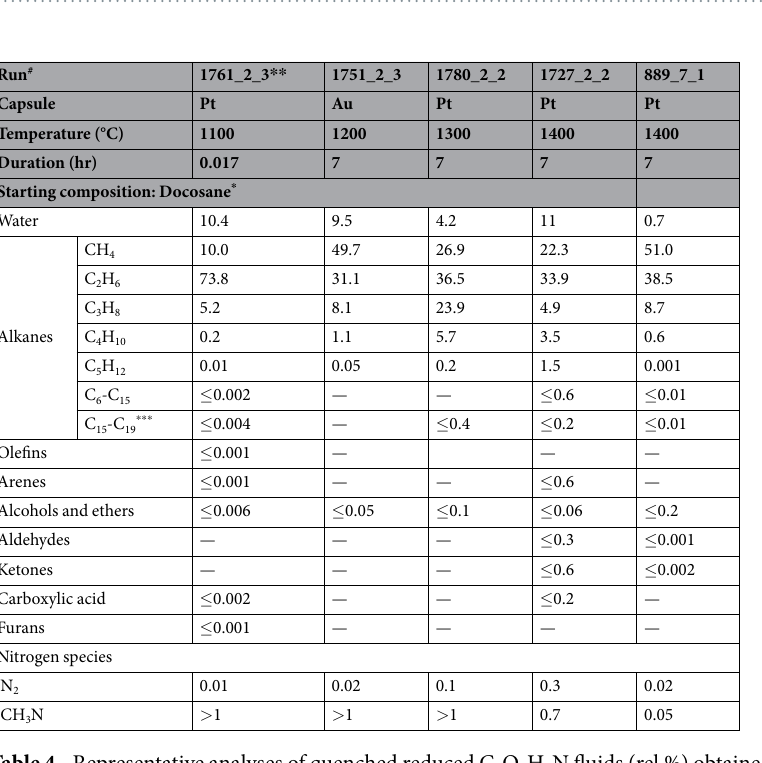
Table 4. Representative analyses of quenched reduced C-O-H-N fluids (rel.%) obtained in runs at 6.3 GPa and 1100–1400 °C. * All samples contained graphite; ** Data given for comparison. *** The quoted concentrations are maximum for a species of the respective group. All GC-MS data are given in Supplementary Table